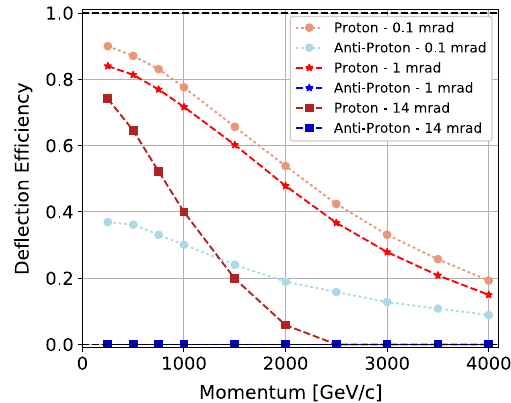
Fig. 1 Dependenceofthechannelingefficiencyofprotonsandantipro- tons with the particle momentum for 1 mm, 1cm and 7cm long Si crystals bent along the (110) plane by a 0.1, 1 and 14mrad bending angle, respectively. The curves for the anti-proton interacting with the 1 and 7cm long Si crystals are